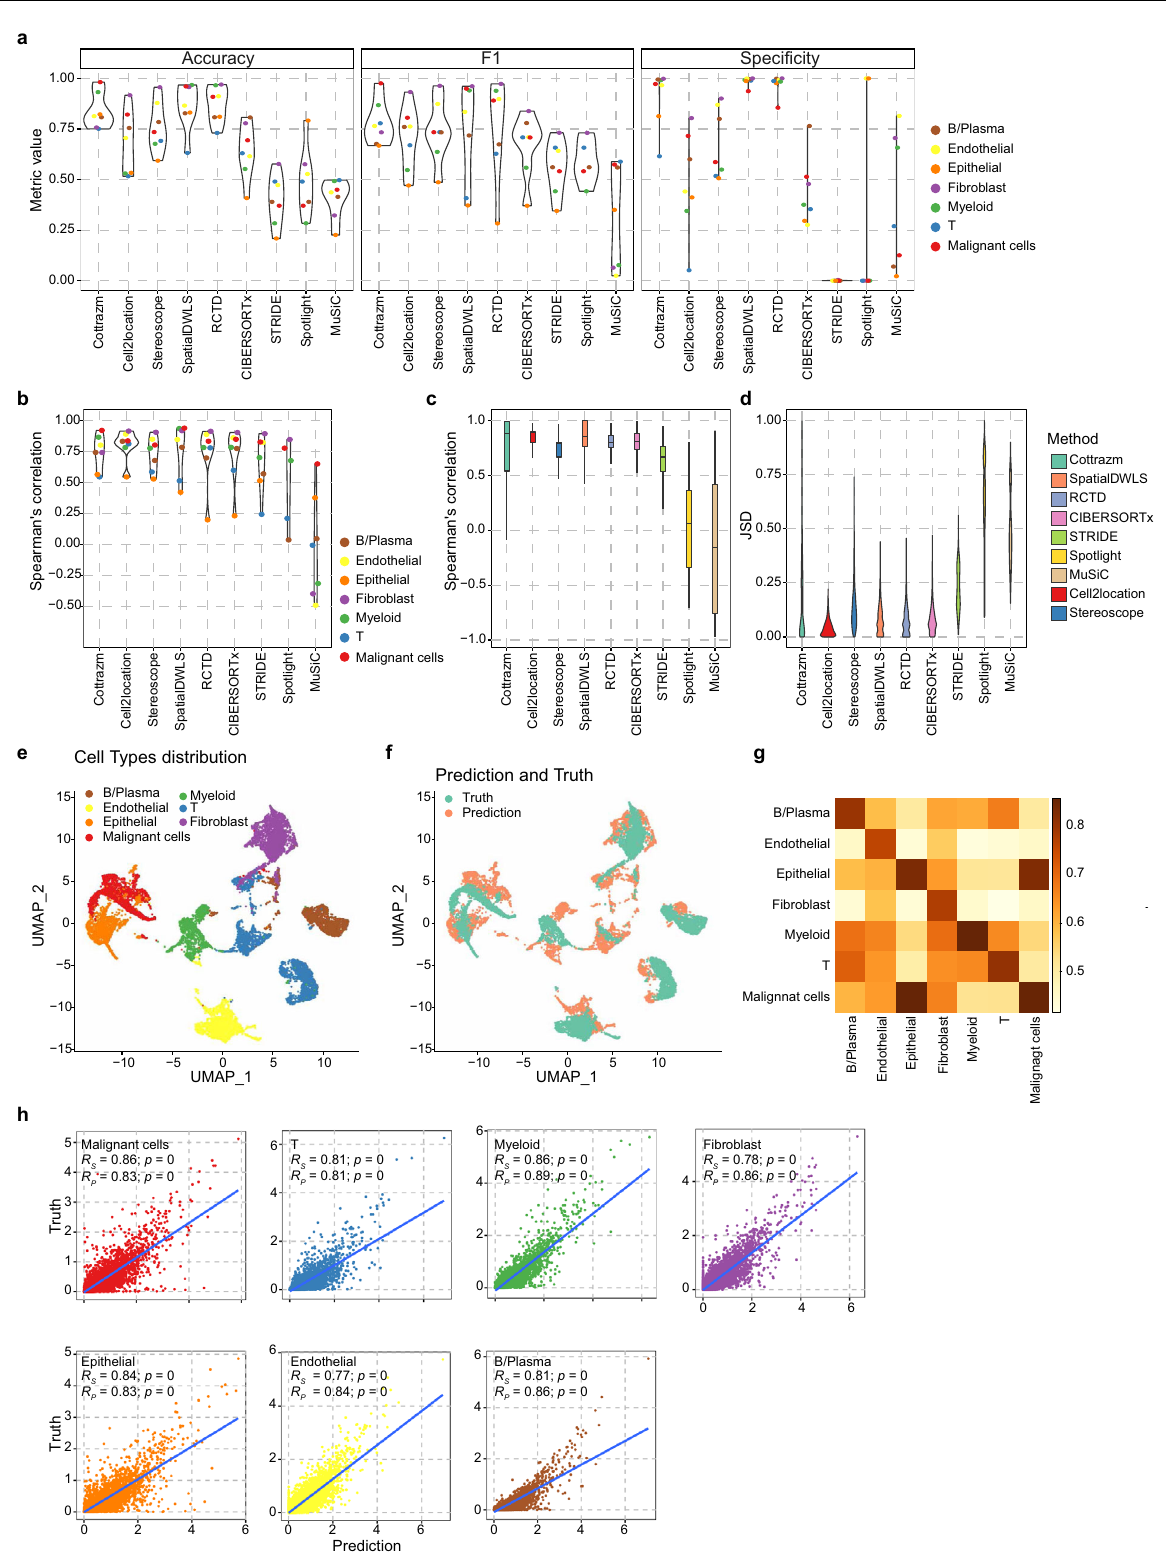
of chronic in fl ammation, including tumors, and represent a promising avenue for cancer immuotherapy 30,55 – 59 . Spots in TLSs consisted of a greater percentage of T cells and B/Plasma cells, and lower percentage of stromal cells and myeloid cells (Fig. 4a, b). The normal epithelium tissue-related spots had a high proportion of epithelial cells and fewer immune cells and fi broblast cells, while stromal-related spots had